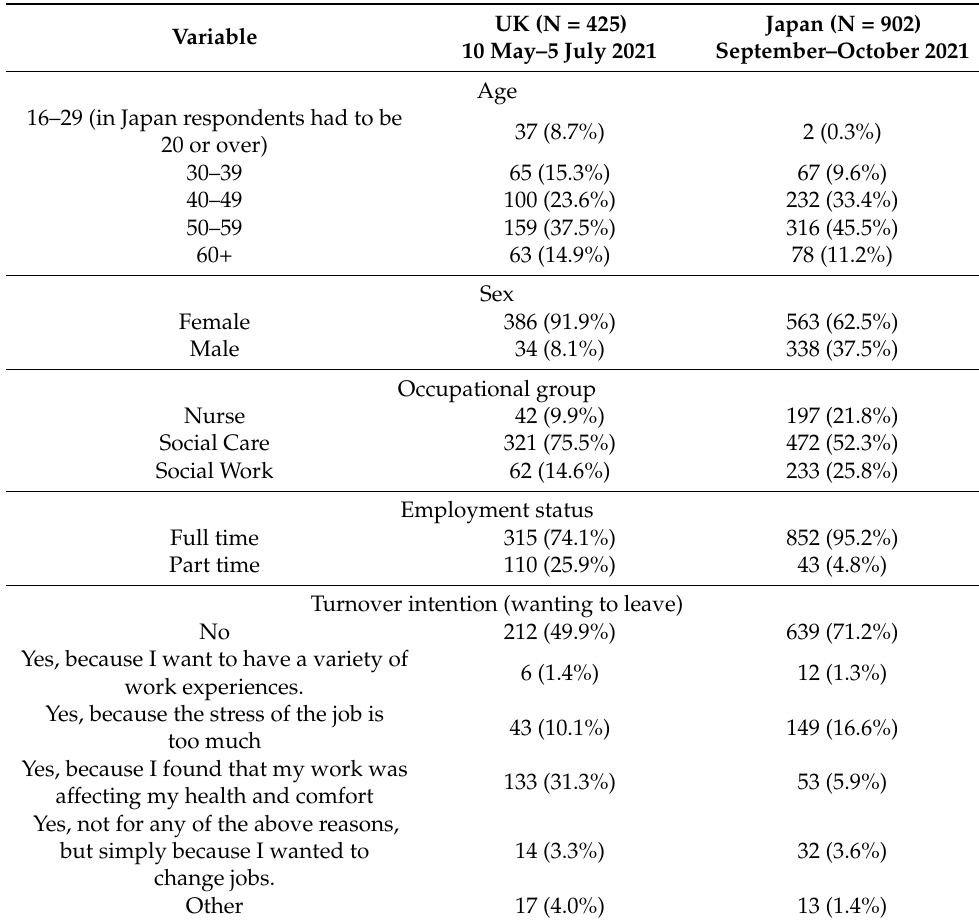
Table 1. Demographic and work-related characteristics of the final